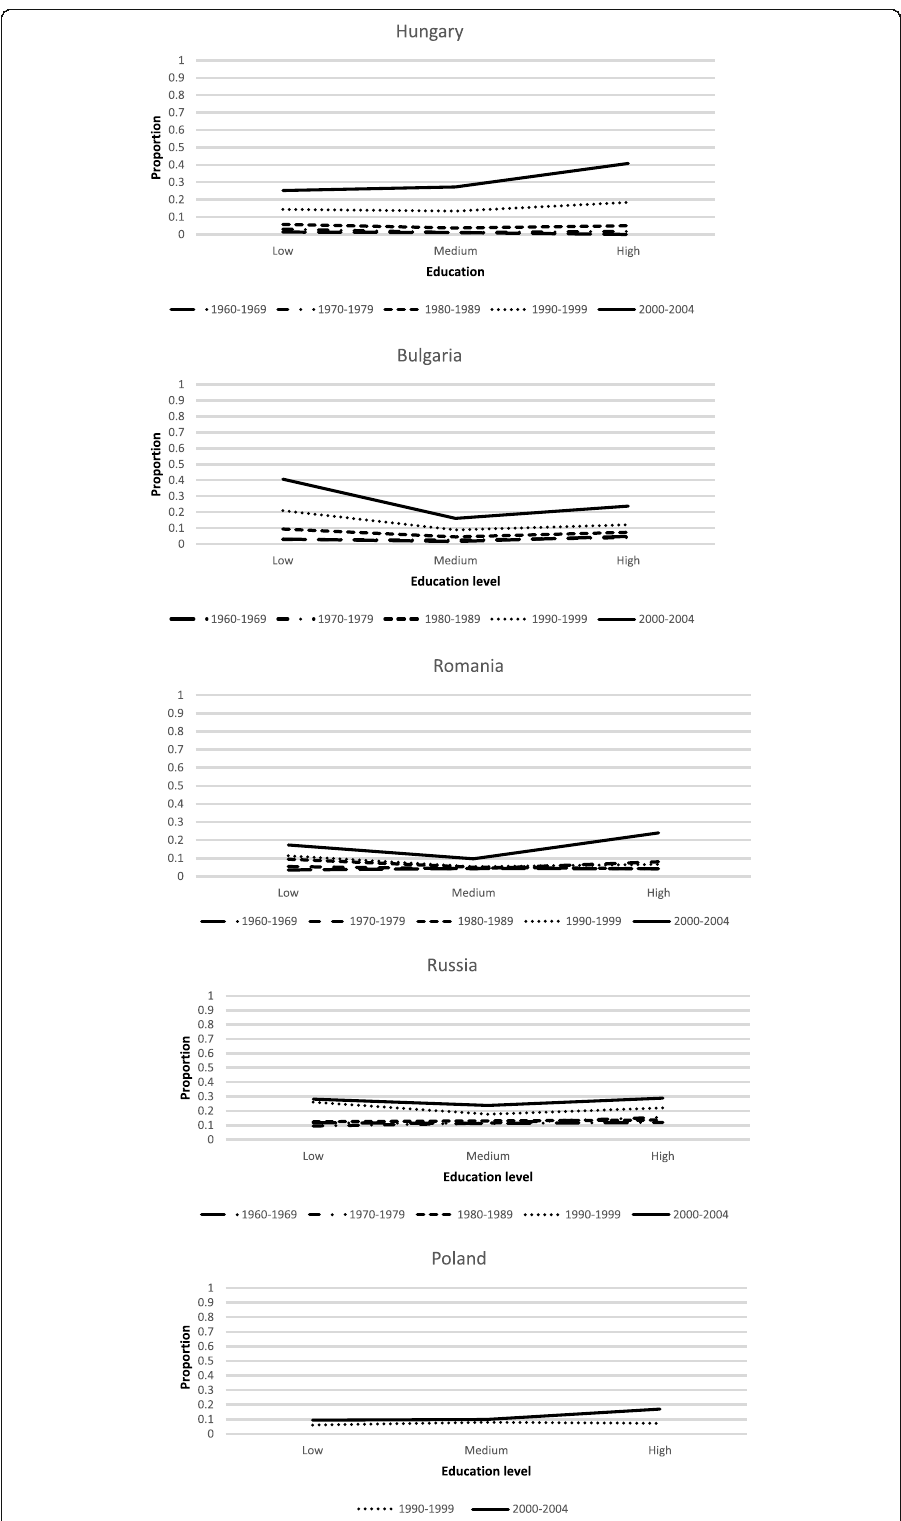
Fig. 6 Expansion of cohabitation by level of education in selected European countries — share of cohabitation for at least 1 year relative to all women 25 – 29 who were in a union (married + cohabiting) for at least 1 year. Source: Courtesy of Jorik Vergauwen, Antwerp University. Data: Gender and Generation Survey harmonised data and national